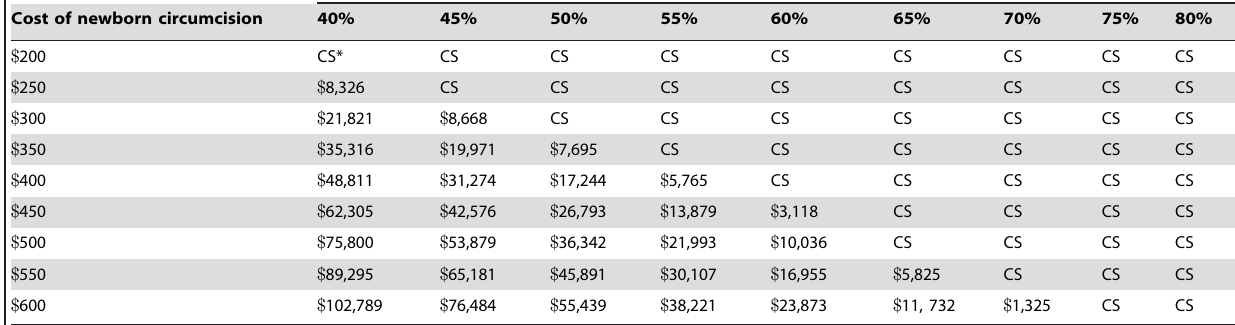
Table 5. Two-way sensitivity analysis of efficacy of circumcision related to heterosexually-transmitted HIV and cost of